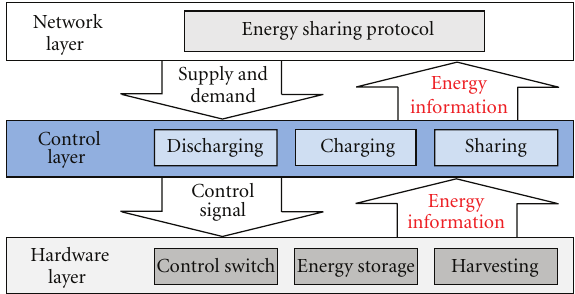
Figure 2: Overview of system